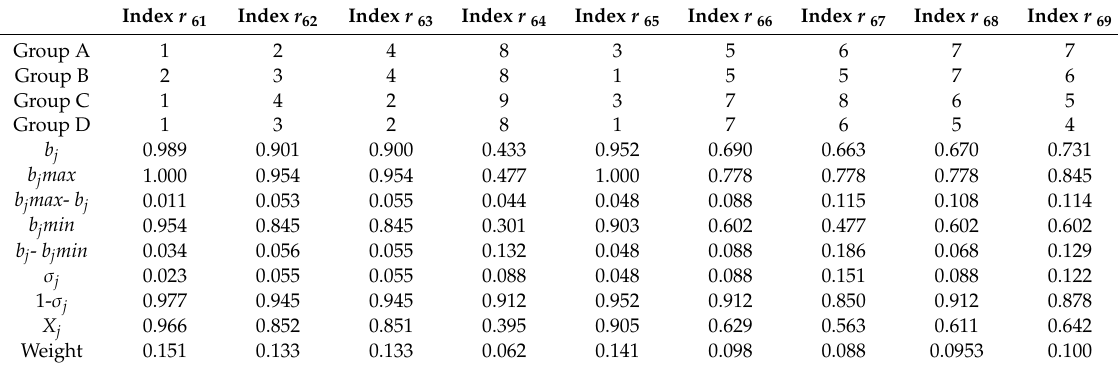
Table A7. Weight distribution of the second grade indexes of r